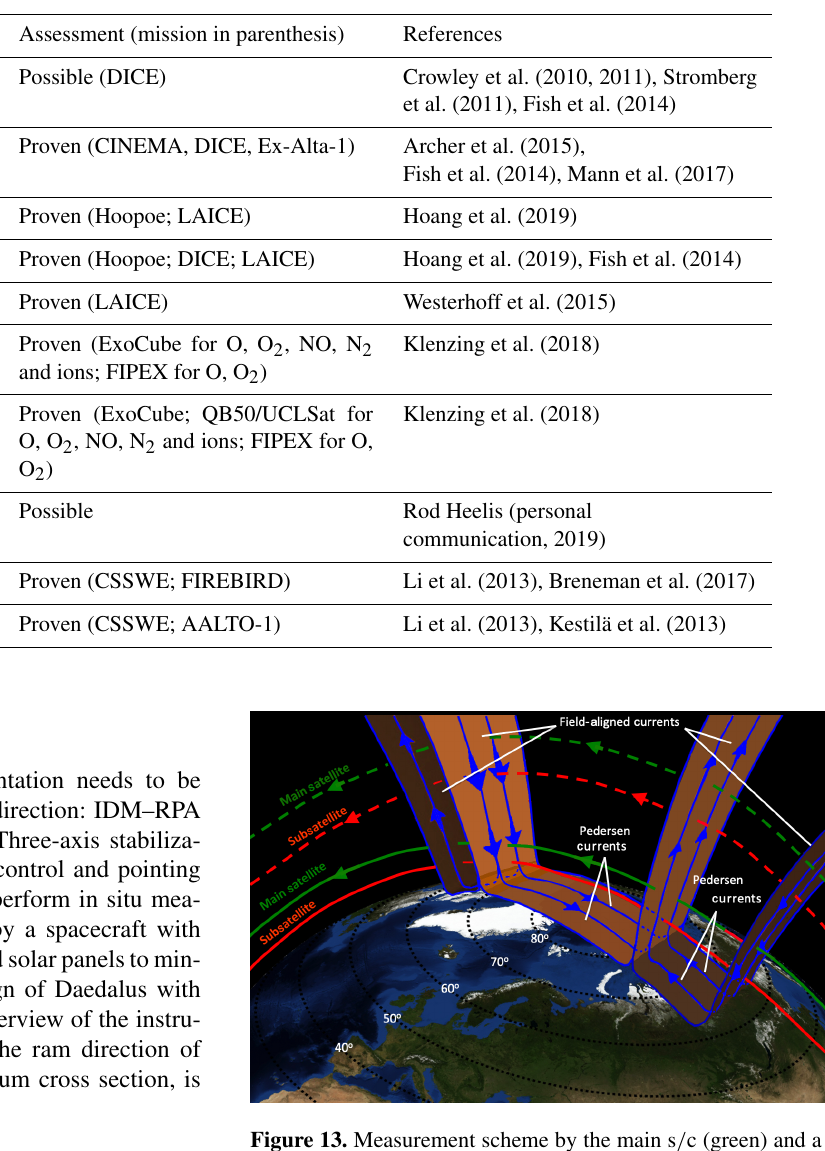
Table 3. List of potential instruments for subsatellite platforms, including a preliminary assessment of feasibility and the missions that have flown the corresponding instruments.